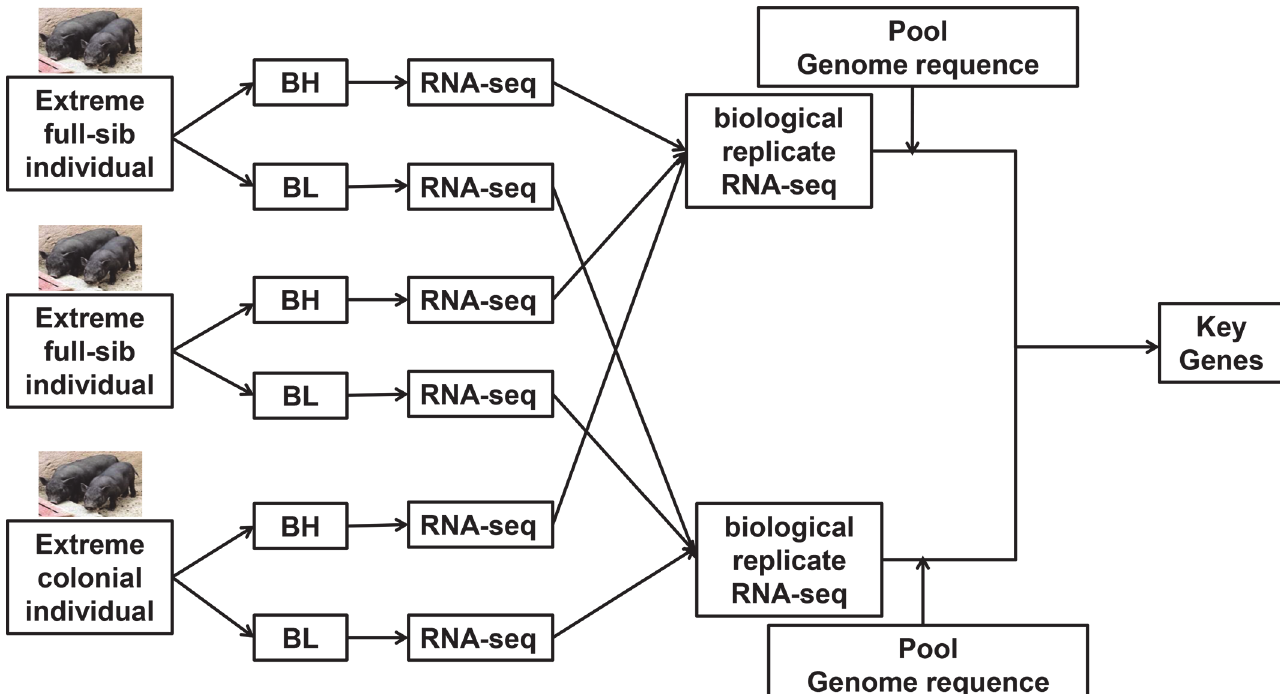
Fig 1. Experimental study design. Schematic picture of the experimental design. Two of three pairs extreme individuals are full-sibs. BH: Songliao Black pigs with higher backfat of live group. BL:Songliao Black pigs with lower backfat of live group.